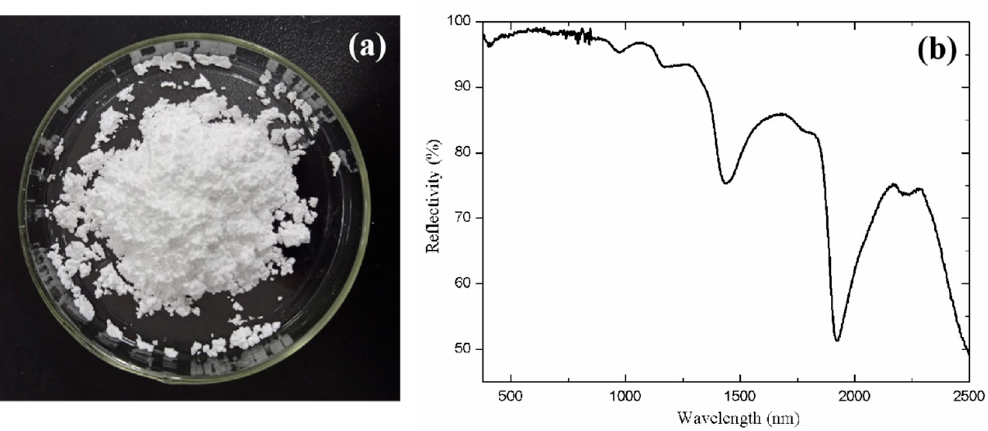
Figure 2. ( a ) Optical photograph and ( b ) solar spectral reflectance profile of the 4A zeolite.